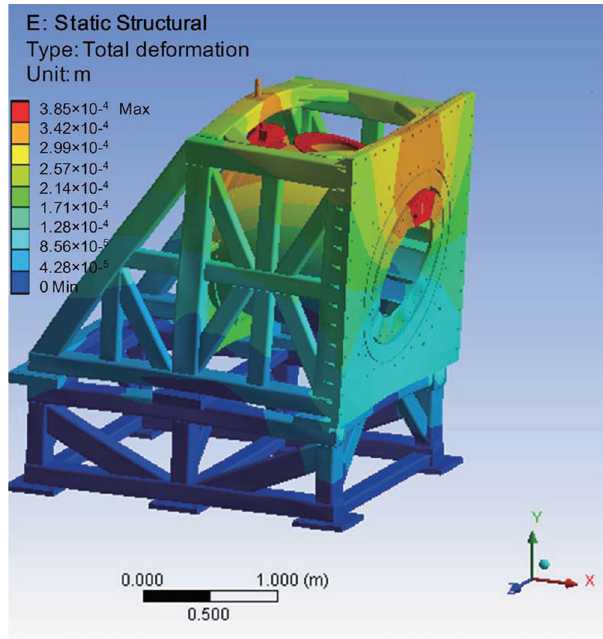
FIG. 10. Deformation distribution computation and analysis when taking all load into consideration. Results show a maximum deformation of 0.38 mm is induced. The deformation is accept- able in engineering.